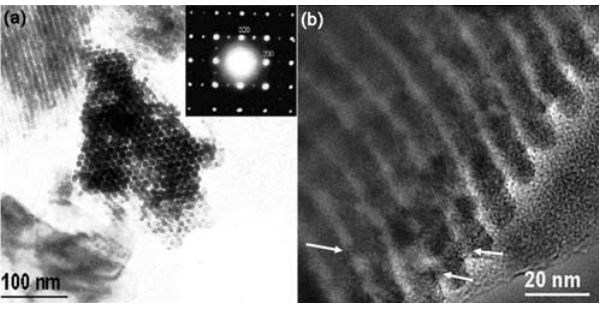
Figure 3. (a) TEM image of 3D mesoporous single crystals of WO shows a SAED pattern from many nanorods when viewed down the [001] zone axis of the unit cell. (b) TEM image showing some bridges indicated by arrows [102]. WO 3 (Reproduced by the permission of